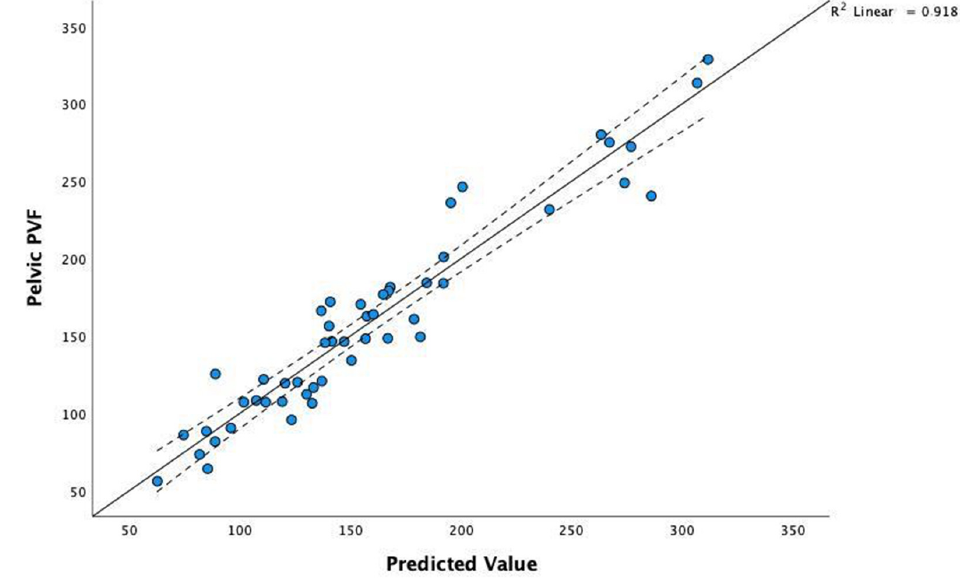
Figure 4. Correlation scatterplot of pelvic PVF for the observed values and those predicted by the model.